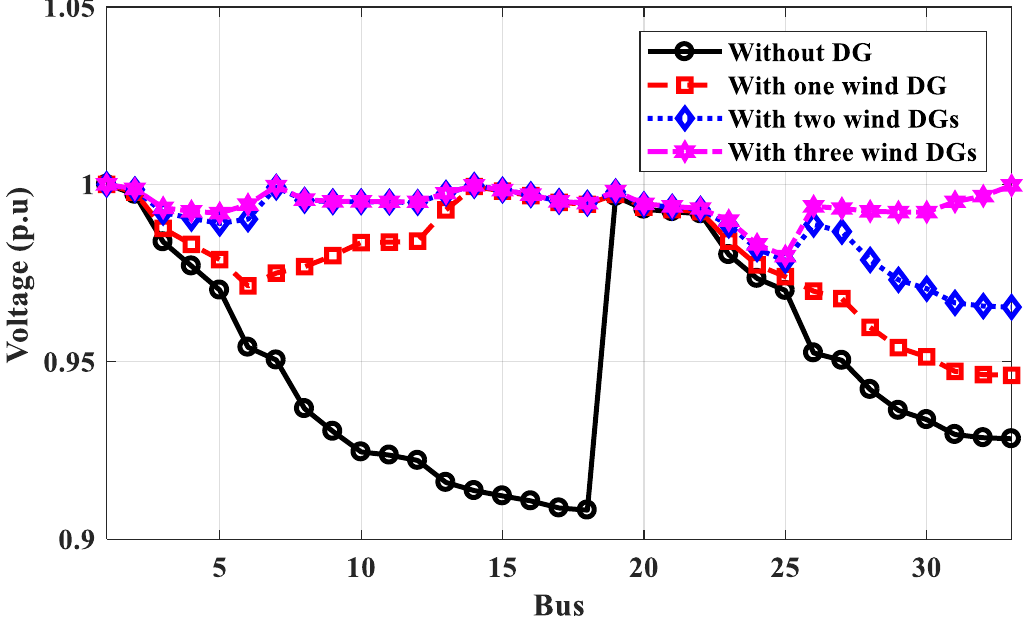
Figure 15. Voltage profile of IEEE 33-bus without and with wind farm DGs for annual energy loss Figure 15. calculation.